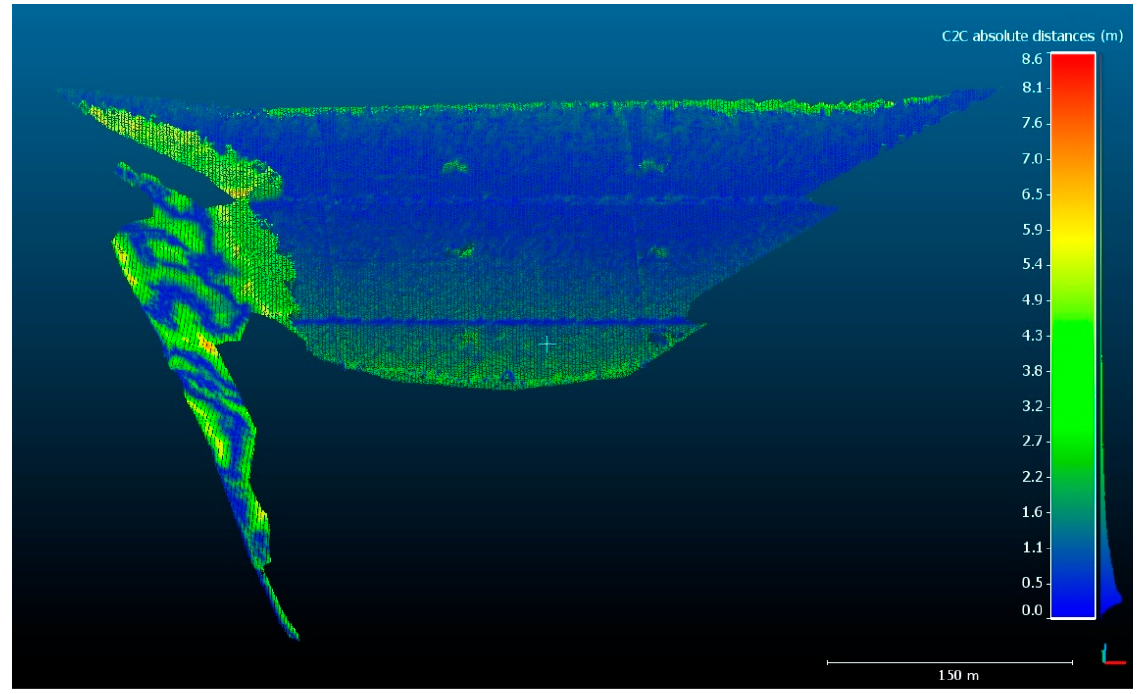
Figure 12. The difference map between the X-band TomoSAR imaging result and the LIDAR data of the fieldwork at Zipingpu Dam; the difference is the absolute value (absolute distance) of the difference. Table 2. The results of the validation statistics.